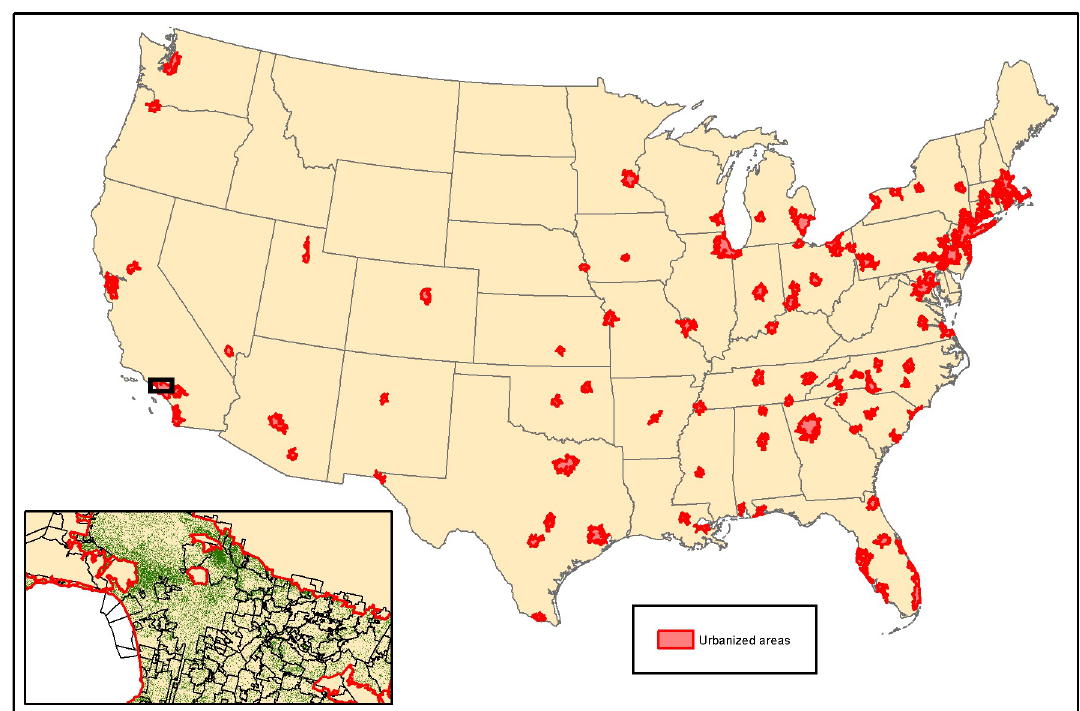
Fig 1. Urbanized areas mapped in this study. Tree cover was mapped for 2016. An inset map of the tree cover (green) of a portion of the Los Angeles urbanized area is shown. Within the area mapped in the inset, there were 93 municipalities and 34 census-designated places, whose outlines are shown with black